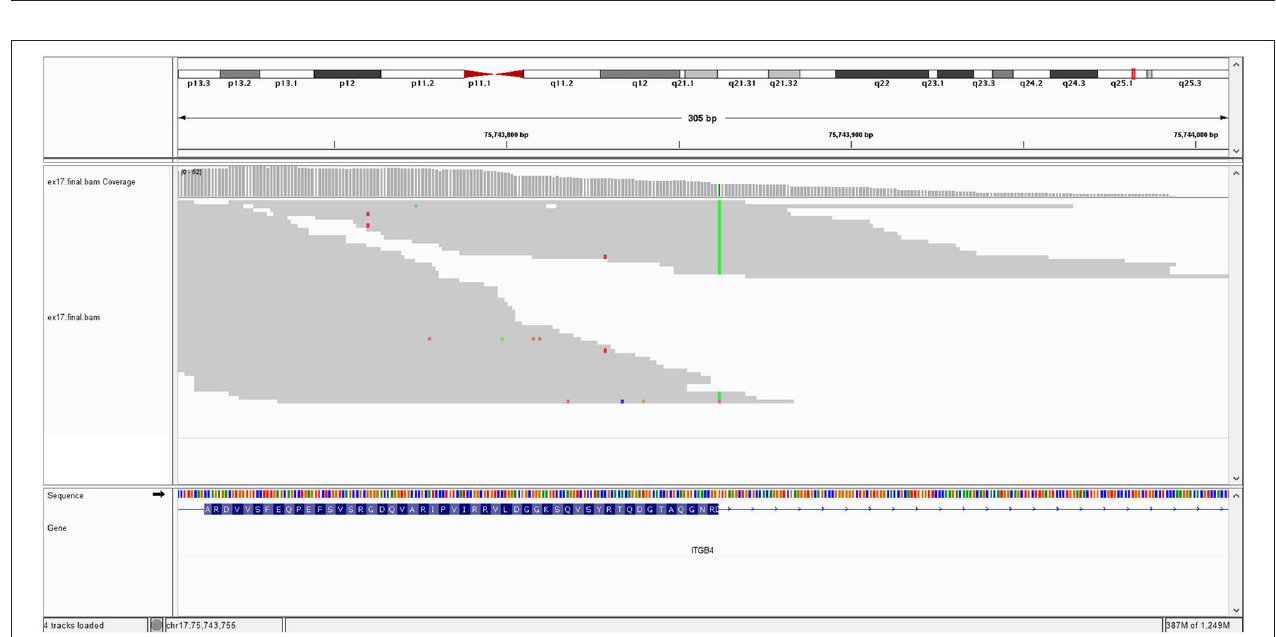
FIGURE 2 | KRT10 gene